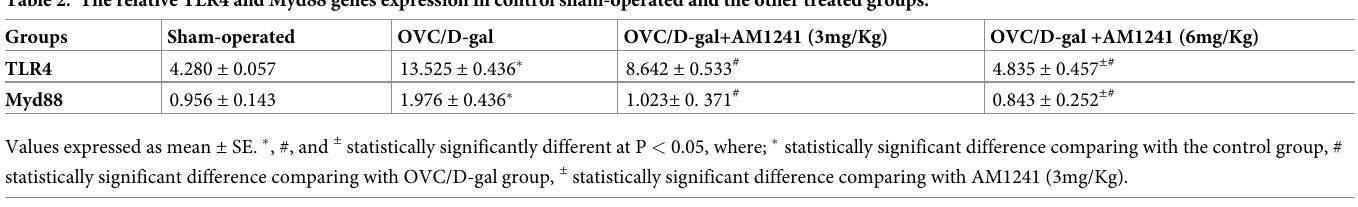
Table 2. The relative TLR4 and Myd88 genes expression in control sham-operated and the other treated groups. Groups